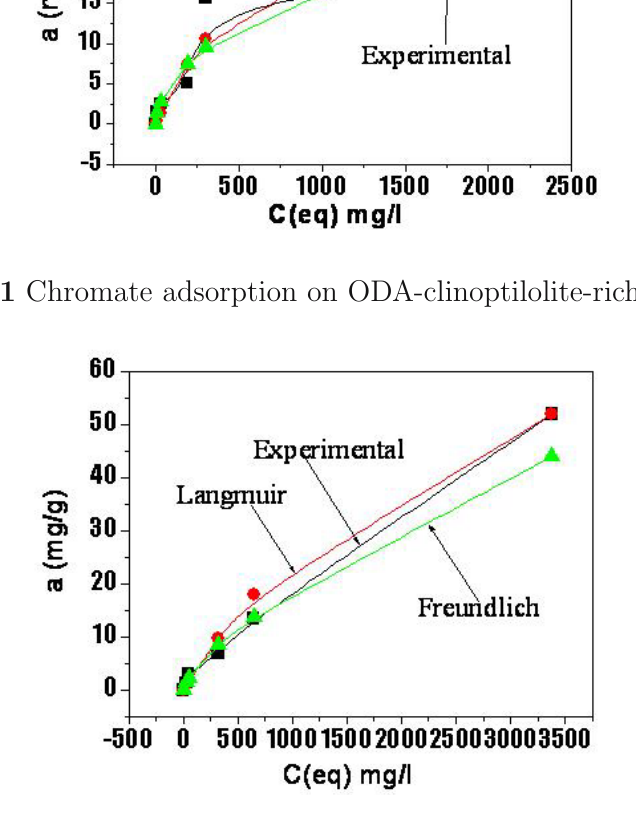
Fig. 2 Arsenate adsorption on ODA-clinoptilolite-rich tuff.